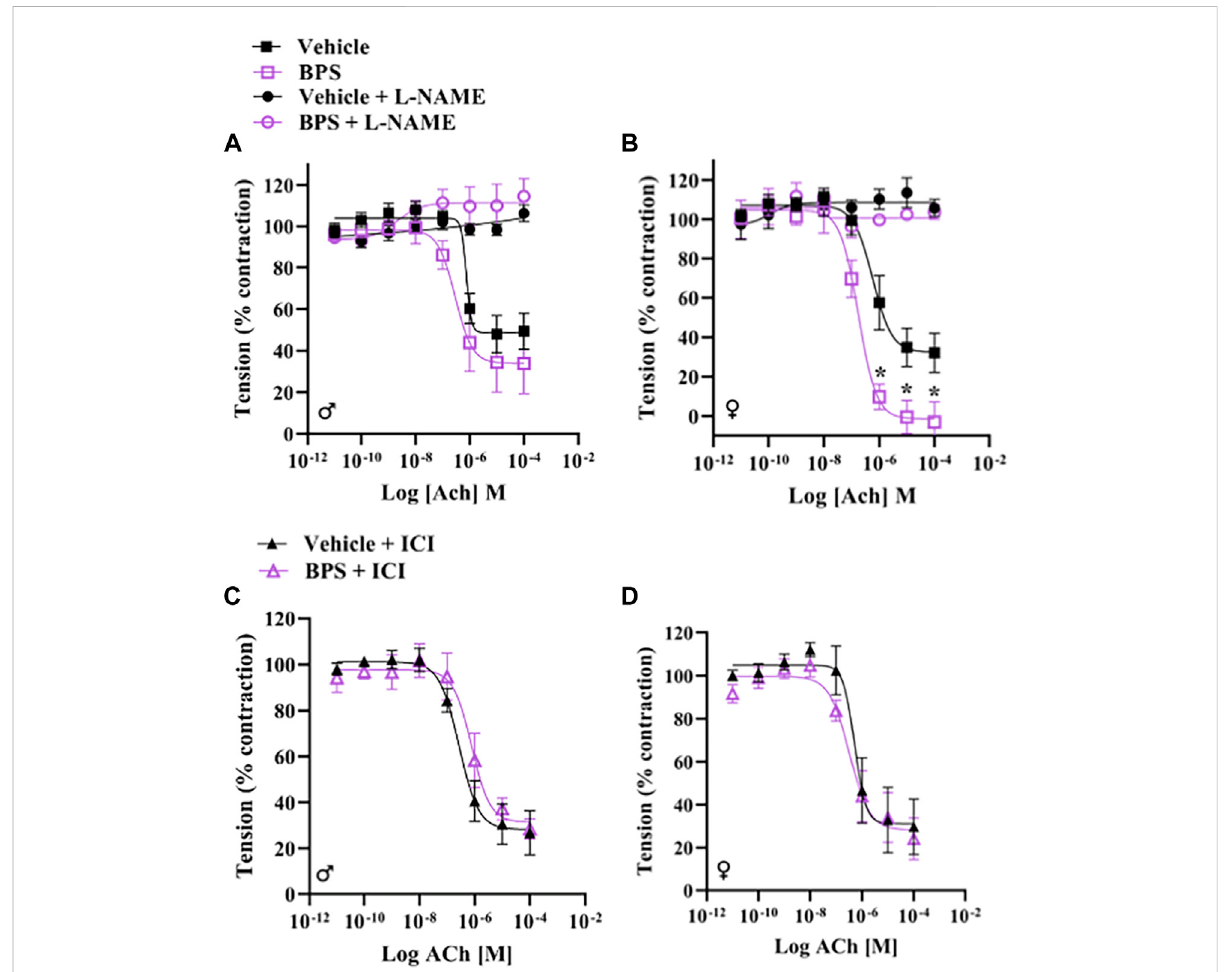
FIGURE 5 BPS-induced augmentation of dilation in female vessels is mediated by eNOS and ER. Aortic rings from male or female mice were mounted onto a wire myograph and exposed to BPS or vehicle for 30 min prior to generating concentration response curves to ACh. ACh-induced vasodilation was calculated as the % pre-contraction tension. Dilatory responses to ACh in the presence or absence of L-NAME in (A) male or (B) femaleaorticrings.ACh-induceddilatoryresponsesinthepresenceoftheERantagonist,ICI,in (C) maleor (D) femaleaorticrings.Curveswere compared by Two-way ANOVA followed by Sidak ’ s post hoc test. * p < 0.05; **, p < 0.01; ***, p < 0.001 BPS vs. vehicle.